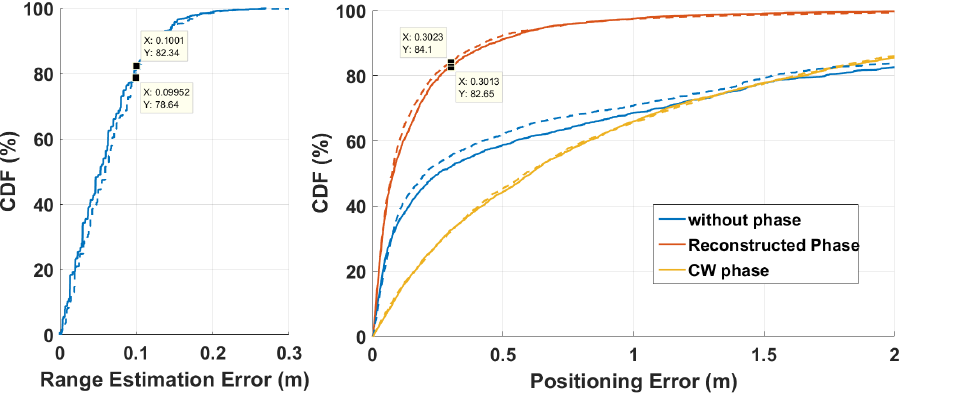
Figure 15. Cumulative distribution function for range estimation error and positioning error; dashed curves are related to estimation in the 4.75–6.25 GHz frequency